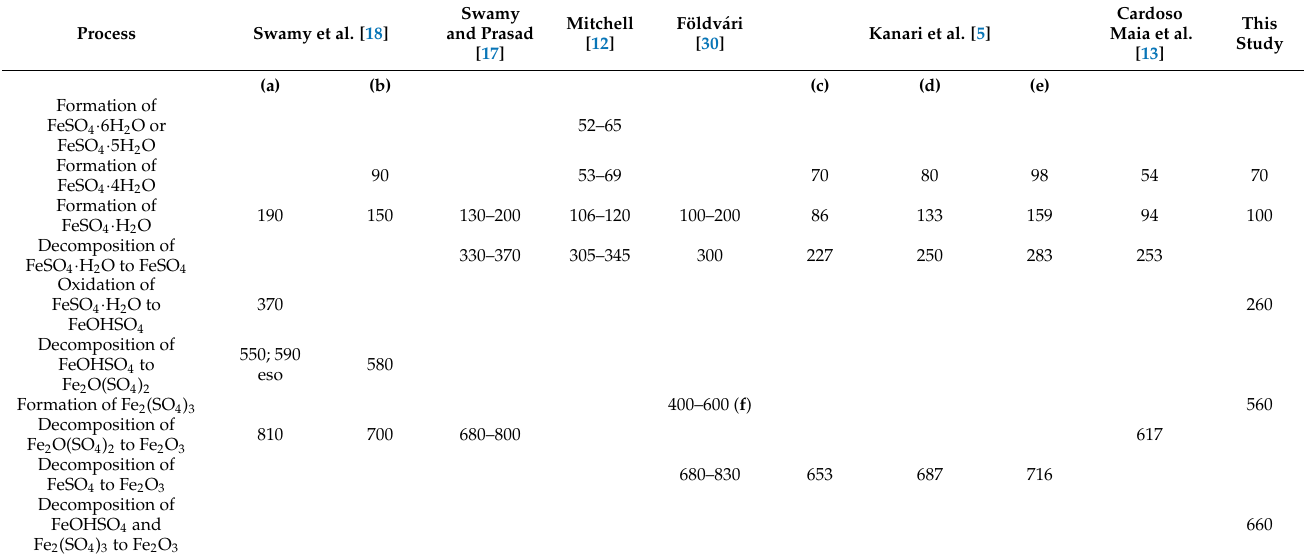
Figure 1. Thermogravimetry (TG) (blue), differential thermal analysis (DTA) (black) and derivative thermogravimetric (DTG) (red) curves of melanterite from Fornovolasco. Endothermic peaks in the DTA curve are centered at 70, 100, 260, 500–560 and 660 °C. Table 1. Data (°C) from the DTA curve of the literature and studied FeSO 4 ·7H 2 O compound.